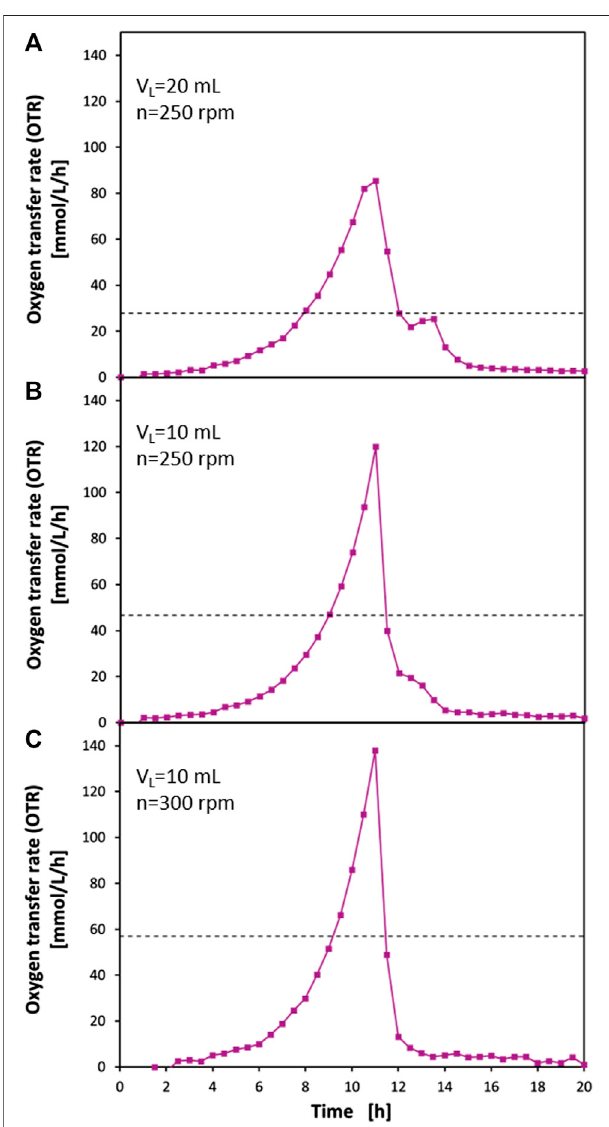
FIGURE5| Oxygen transfer rates(OTR) from cultivations of E. coli BL21 in mineral medium in perforated ring fl asks with inner vessel diameter d i = 80 mm, inner ring diameter d ring,i = 70.6 mm, wall thickness d wall = 2.2 mm, and 2 perforations of 3 mm × 3 mm size. The full lines with data points show OTRs measured with RAMOS. (A) fi lling volume V L = 20 ml; shaking frequency n = 250 rpm. (B) V L = 10 ml; n = 250 rpm. (C) V L = 10 ml; n = 300 rpm. (C) is shifted by 1.5 h. The dashed horizontal lines represent the predicted OTR max levels for 250 ml shake fl asks at the corresponding conditions according to Meier et al. (2016). Experimental conditions: Wilms- MOPS medium with 23 g/L glucose; temperature T = 37 ° C; shaking diameter d 0 = 50 mm; initial optical density OD 600 =